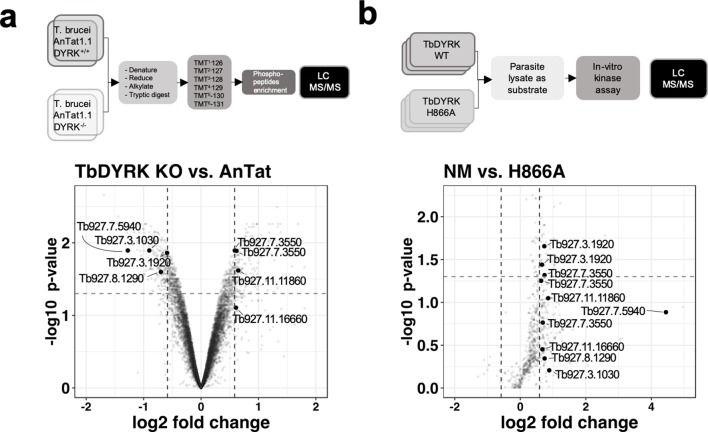
Phosphoproteomic analysis for the identification of substrates of TbDYRK.(a) Quantitative phosphoproteomic analysis by TMT isobaric tagging comparing the proteome of WT cells (T. brucei AnTat1.1 DYRK+/+) or cells deleted for TbDYRK (DYRK-/-). Top panel: flow chart. Lower panel: Volcano plot of the phosphopeptides with the log2 of the fold change (FC) on the x-axis and the -log10 of the p-value on the y-axis. Vertical dotted lines indicate a |FC| > 1.5 and the horizontal dotted line a p-value<0.05. (b) Quantitative phosphoproteomic analysis comparing the phosphoproteins of cell lysates incubated with the purified active kinase (NM) or inactive (H866A). Top panel: flow chart. Lower panel: Volcano plot of the phosphopeptides with the log2 of the fold change (FC) on the x-axis and the -log10 of the p-value on the y-axis. Vertical dotted lines indicate a |FC| > 1.5 and the horizontal dotted line a p-value<0.05. Common peptides in both analyses, presenting a differential phosphorylation >1.5 times disregarding the sense of regulation, are highlighted in both volcano plots.